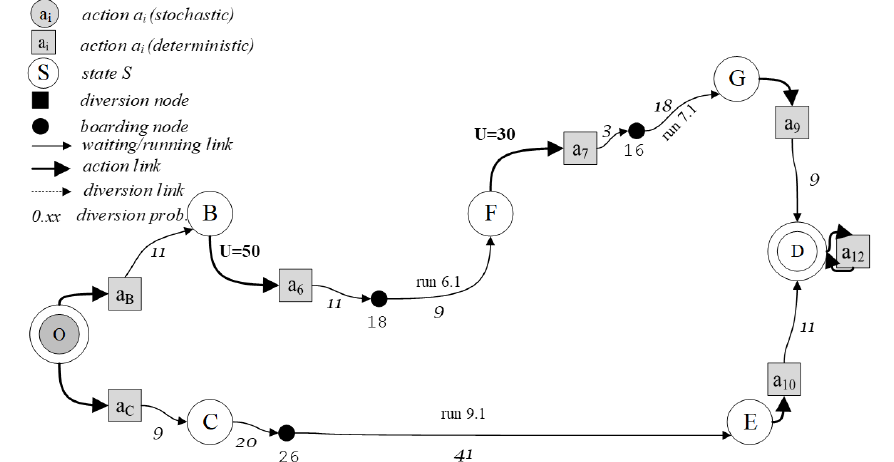
Figure 10. Optimal policies from the origin O, using boarding stop B and boarding stop C.